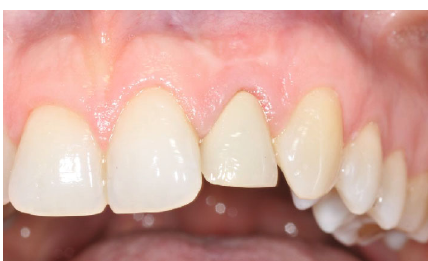
Figure 2: Preoperative clinical condition.